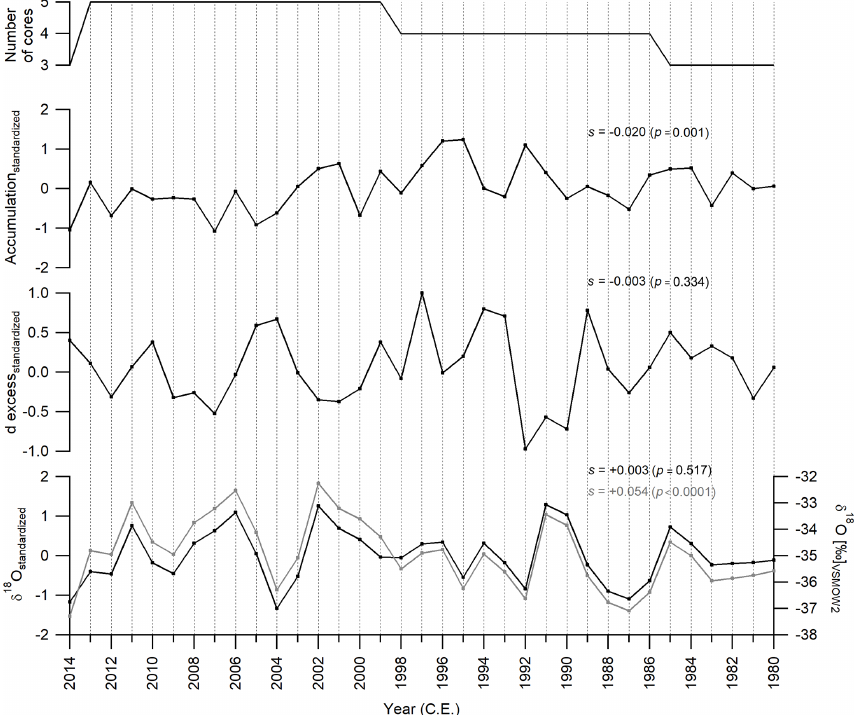
Figure 8. Composite records of mean annual δ 18 O, d excess and snow accumulation in the UG region for the period 1980–2014 derived from standardized data (black; excluding firn core GUPA-1). Sen slopes ( s ) and p values ( p ) are given for each record. For δ 18 O, the composite record derived from non-standardized annually averaged data (grey) is also displayed as it exhibits a statistically significant positive trend that is worth mentioning ( s in ‰a − 1 ) .